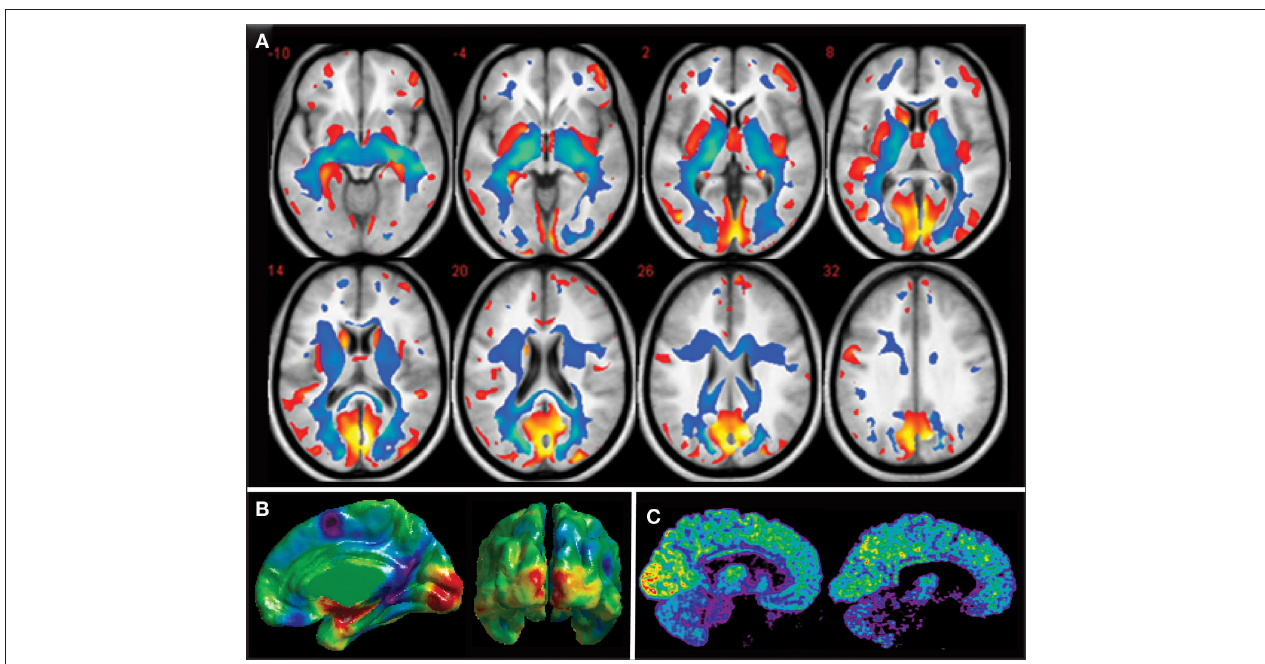
in volume of the occipital cortex, cortical thickness of the cuneus is increased in congenitally blind subjects (unpublished data from our lab). (C) Mid-sagittal brain slices showing increased resting-state glucose metabolism in the congenitally blind brain. Illustrative examples of cerebral glucose metabolism in a congenitally blind (left) and a normal sighted control (right) subject (Kupers et al.,